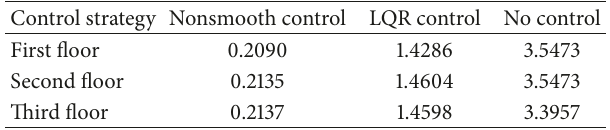
Table 4: Maximum acceleration of each layer of example 2 (m/s 2